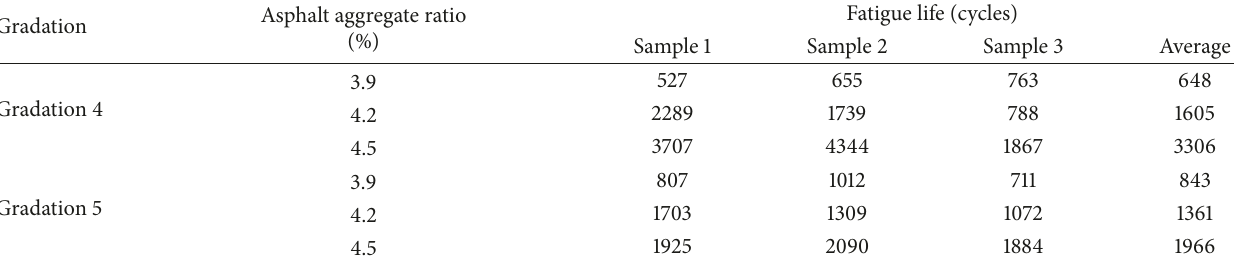
Table 11: Fatigue results.